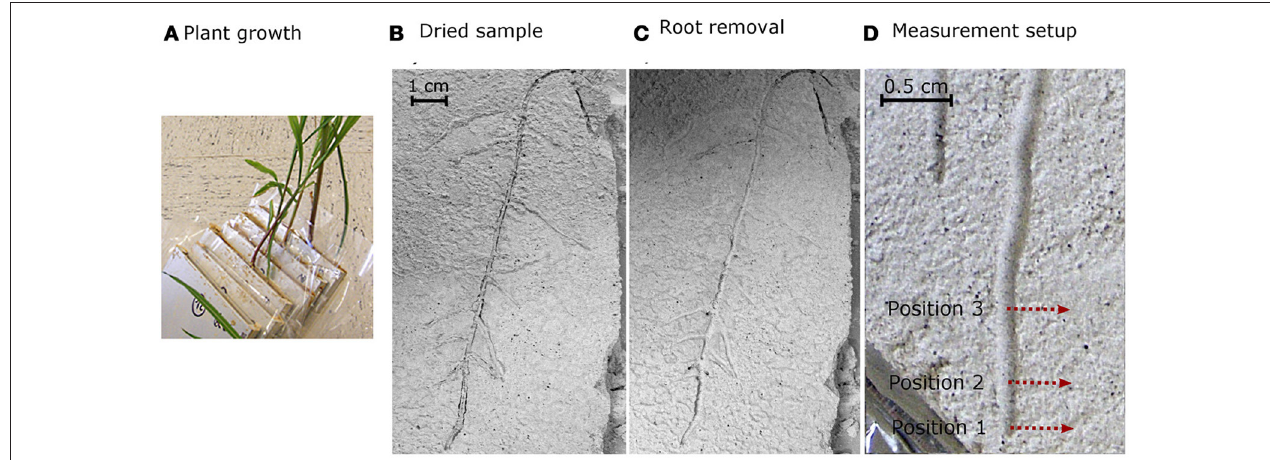
FIGURE 4 | Plant growth (A) and rhizobox with dried soil and plants before (B) and after (C) the roots were excavated from the soil. Measurements were conducted after removing the roots at three position (0, 1, and 3cm behind the tip) perpendicular to the root channel as indicated by the red arrows (D) .